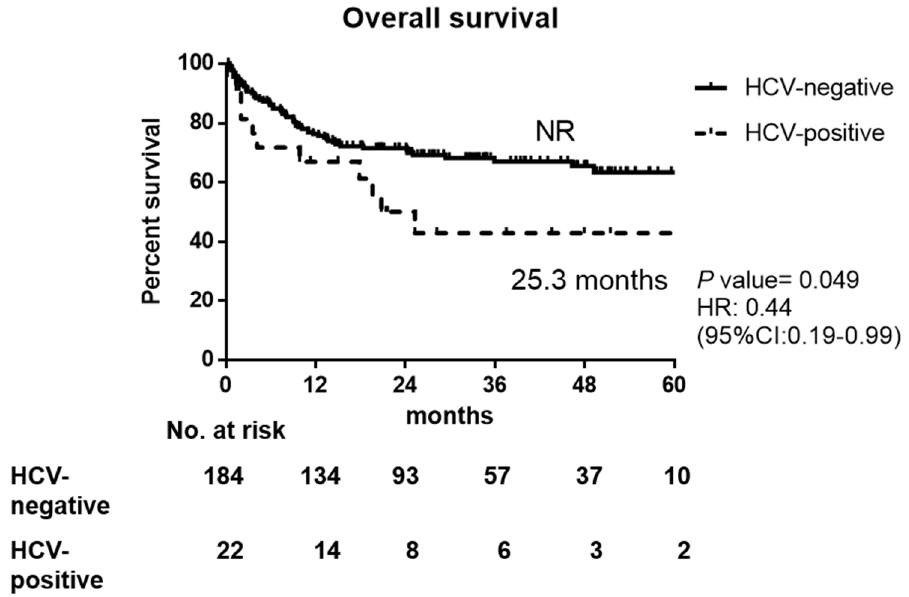
Figure 2. Overall survival of HCV-positive and HCV-negative DLBCL patients. NR: not reached, HR: hazard ration, CI: confidence interval.